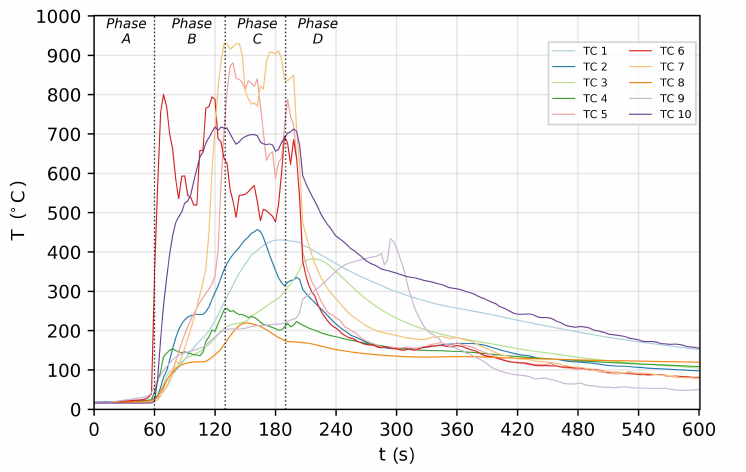
Figure 3. Temperature of thermocouples TC1–TC10 during the first 600 s of the test. Phases A, B, C, and D according to Table 2 and Figure